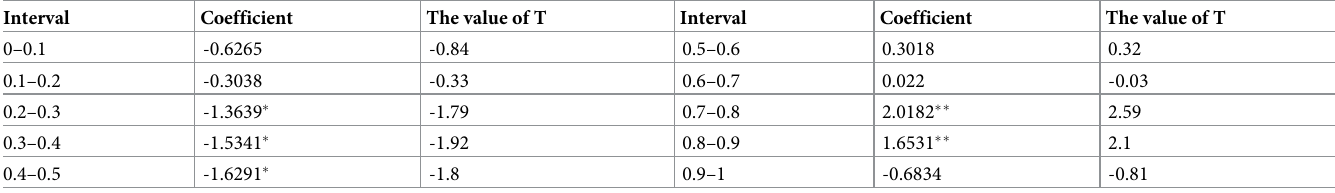
Table 5. The regression results between